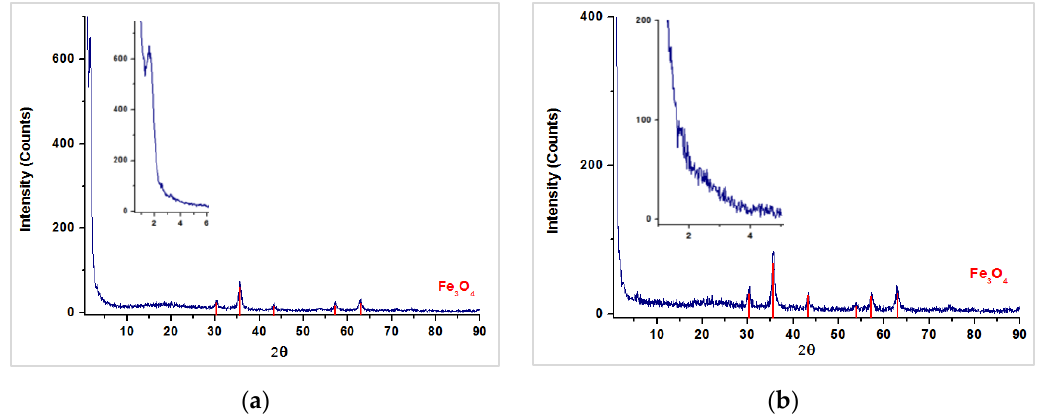
Figure 7. XRD pattern of ( a ) M-Ethylene PMO NPs and ( b ) M-Phenylene PMO NPs.